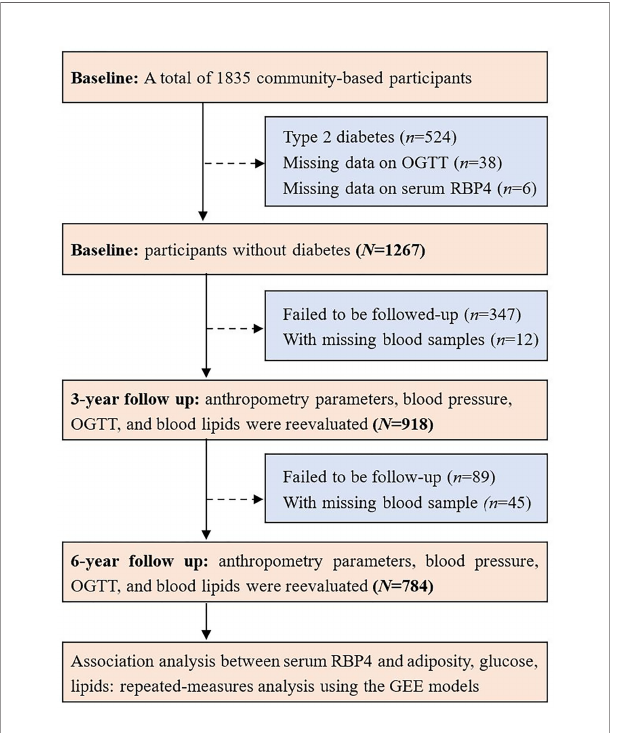
FIGURE 1 | Flow chart of study